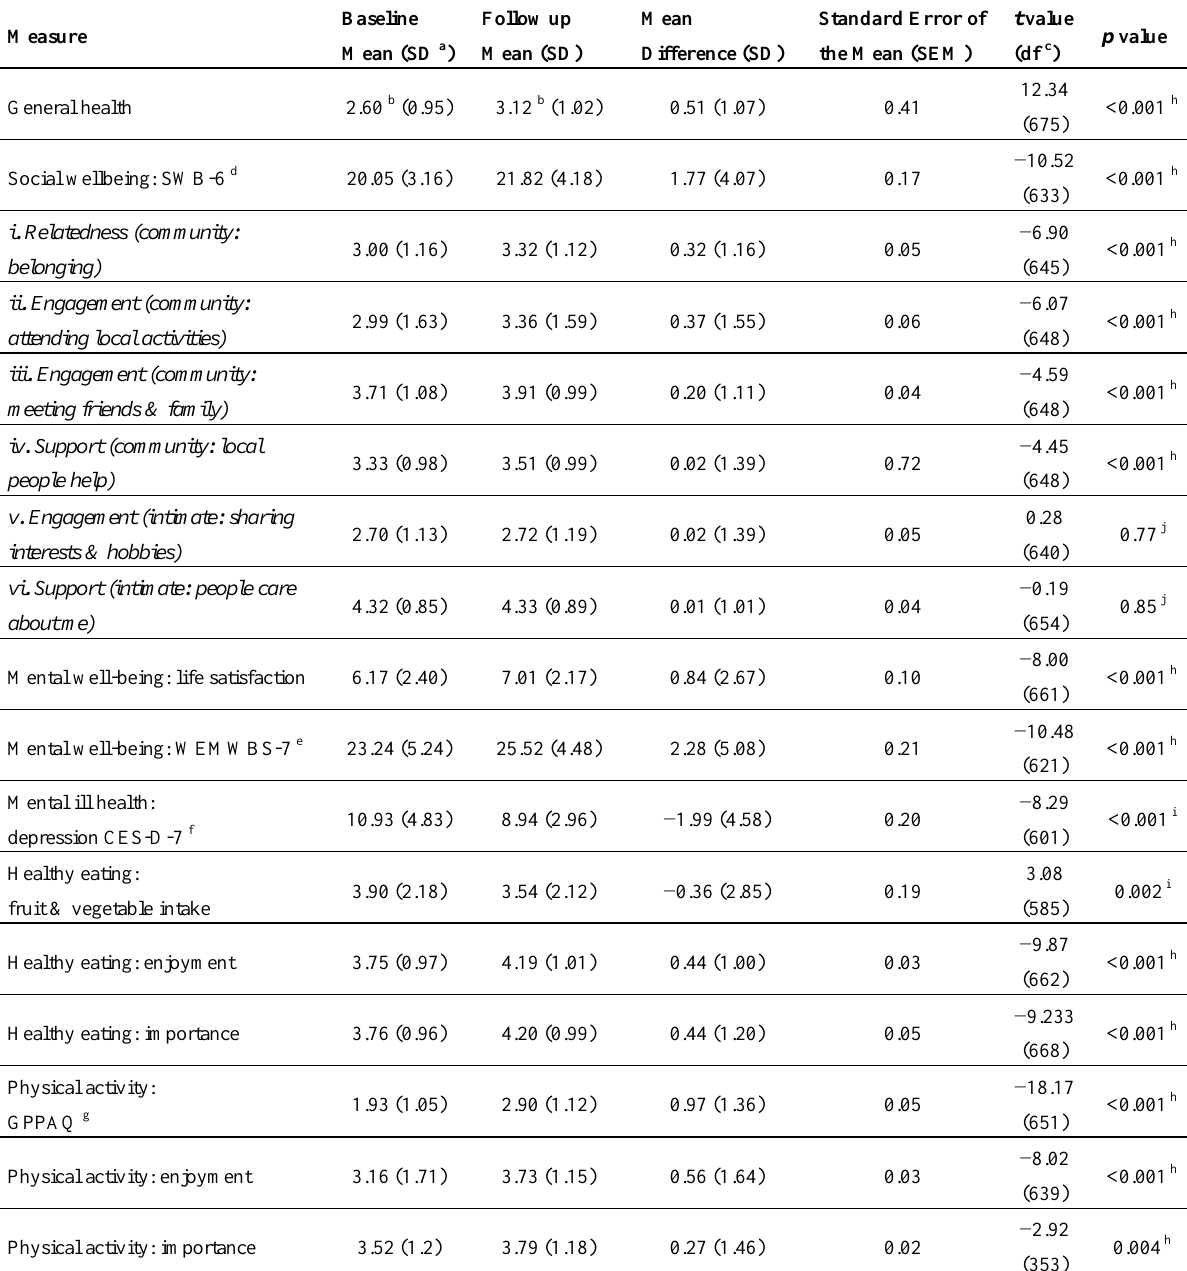
Table 3. Health and wellbeing results: Paired t -tests. N =